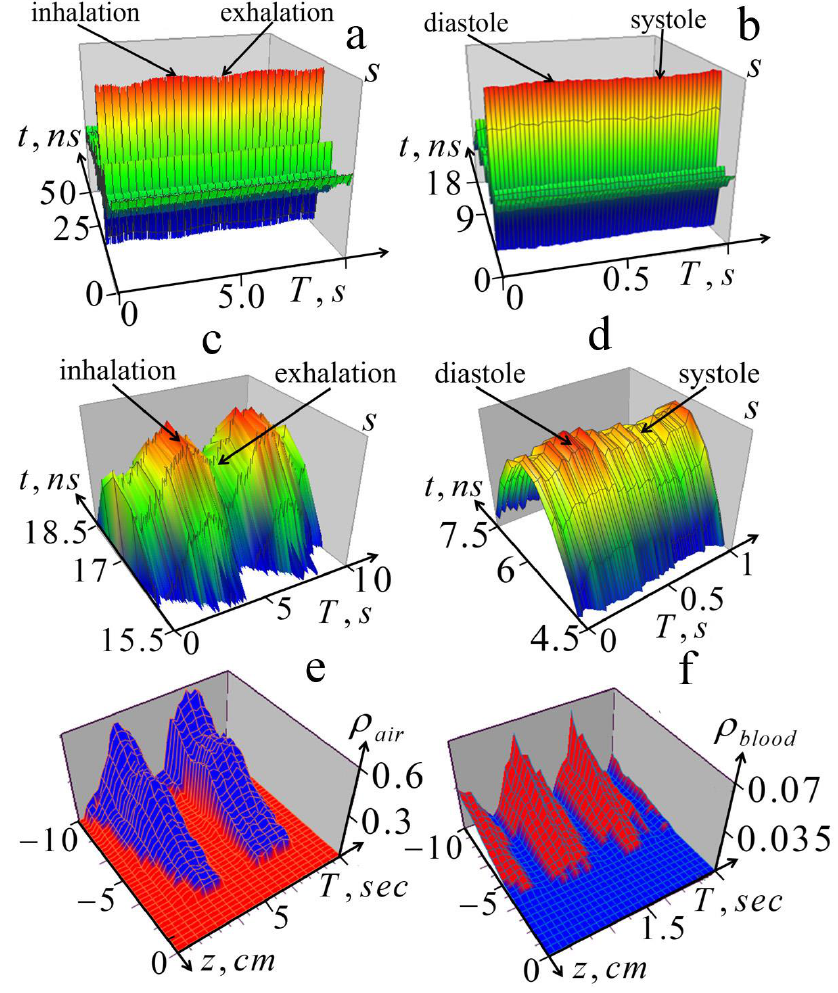
Figure 7. Experimental results of the dynamic 1D tomography (10)–(12) of variations in profiles of the relative air and blood content during breathing and cardiac activity. Upper row: ( a )—variations of the received pulse signal s ( t , T ) associated with breathing; ( b )—variations of the signal associated with cardiac activity (in the phase of full exhalation). Middle row: ( c )—the upper part of the pulse shown in Figure 7a; ( d )—the upper part of the pulse shown in Figure 7b. Bottom row: ( e )—retrieved dynamics of the air content profile ρ air ( z , T ) in the process of breathing; ( f )—retrieved dynamics of the blood content profile ρ blood ( z , T ) during heartbeat.